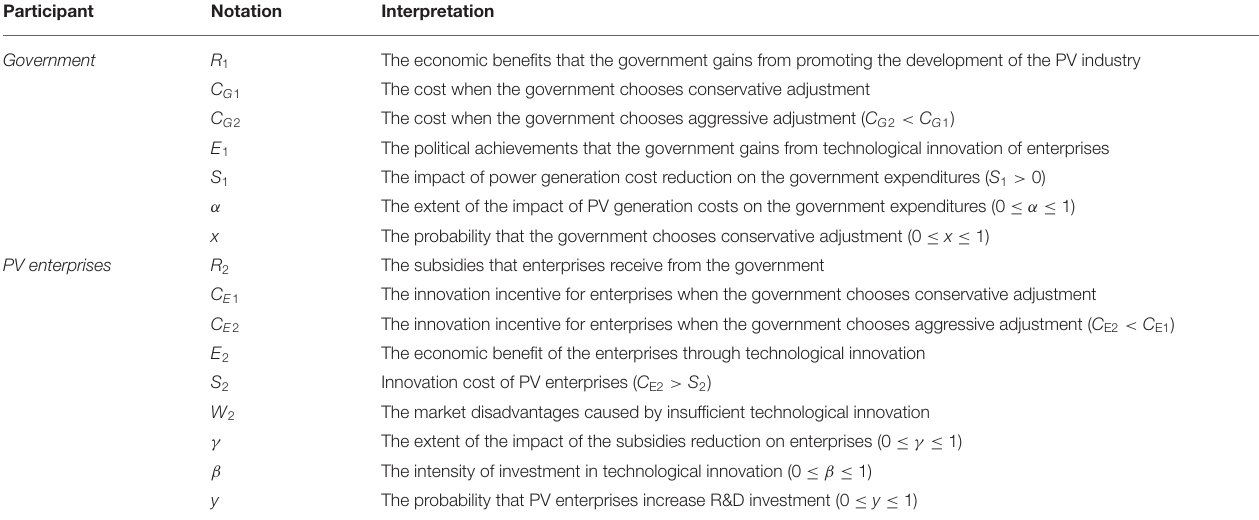
TABLE 2 | Notations and interpretations.